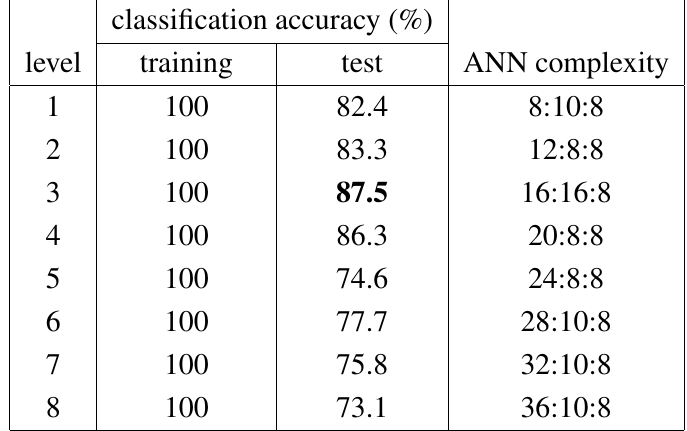
Table 1. Motion classification accuracy with the training and test data, and ANN complexity when the normalized means and variances of DWT decomposition coefficients are used as features.